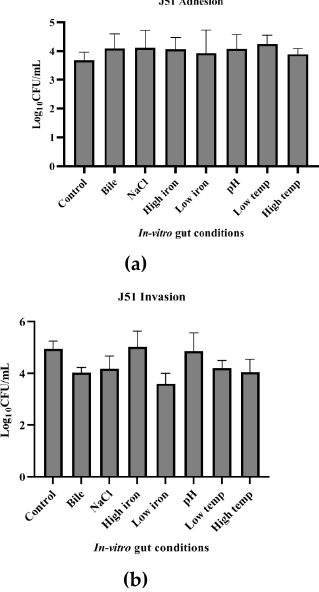
Figure 7. Effect of in vitro gut conditions on adhesion and invasion ability of MDR isolate J51 to Caco-2 cell lines. Error bars represent standard deviations from triplicates. Unpaired t-test was performed and p < 0.05 was considered significant. ( a ) Effect of in vitro gut conditions on adhesion ability of MDR isolate (J51), ( b ) Effect of in vitro gut conditions on invasion ability of MDR isolate (J51)